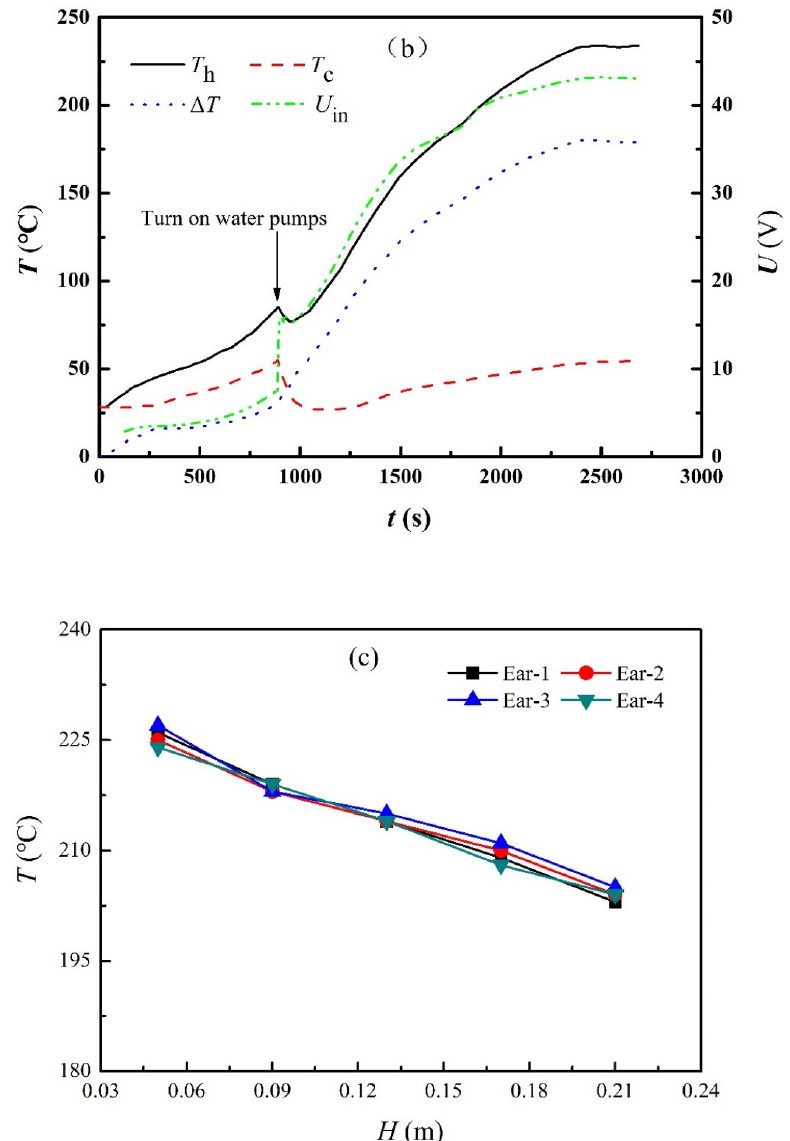
Figure 4. Parameter time history of SPTEG and temperature distribution of heat collector. ( a ) After switching the power source to the SPTEG. ( b ) Self-startup process. ( c ) Temperature variations in the height direction of the heat collector.